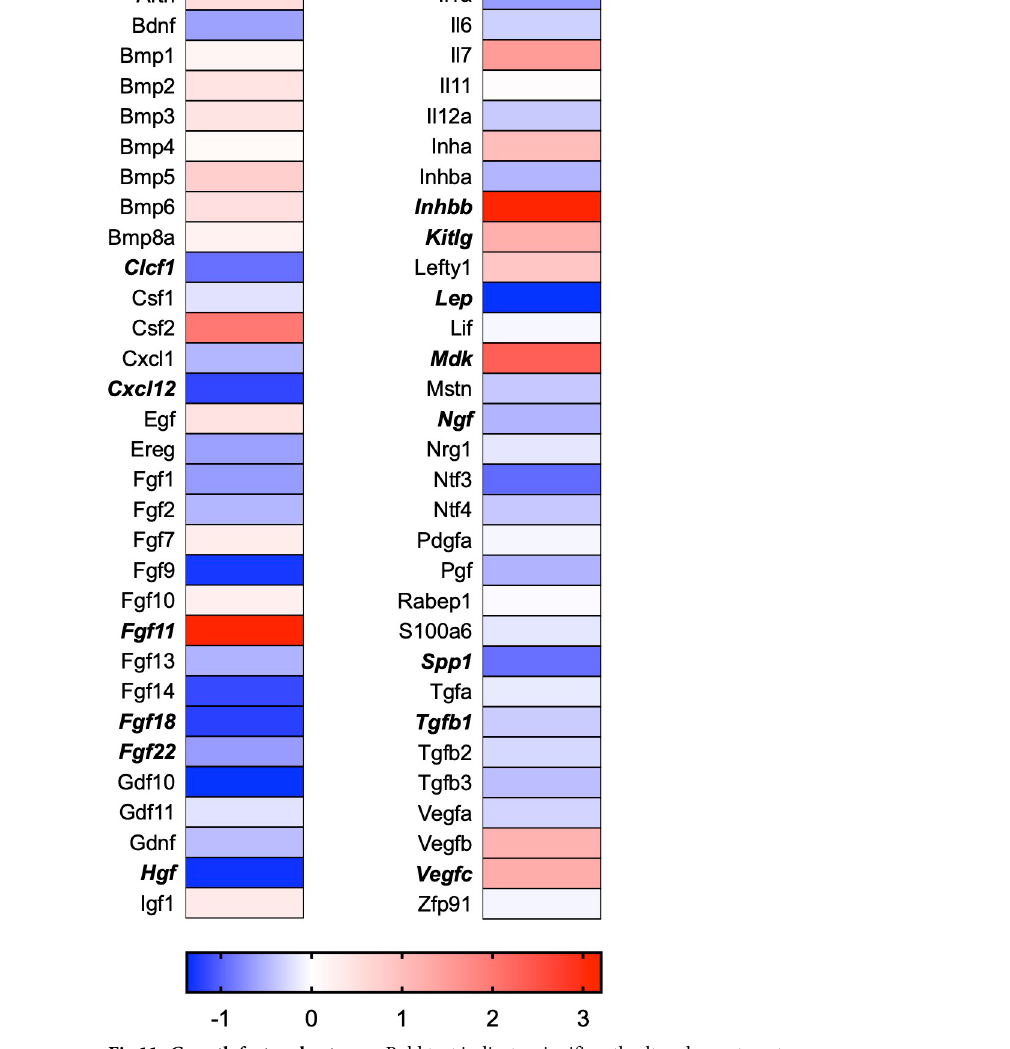
Fig 11. Growth factors heat map. Bold text indicates significantly altered gene